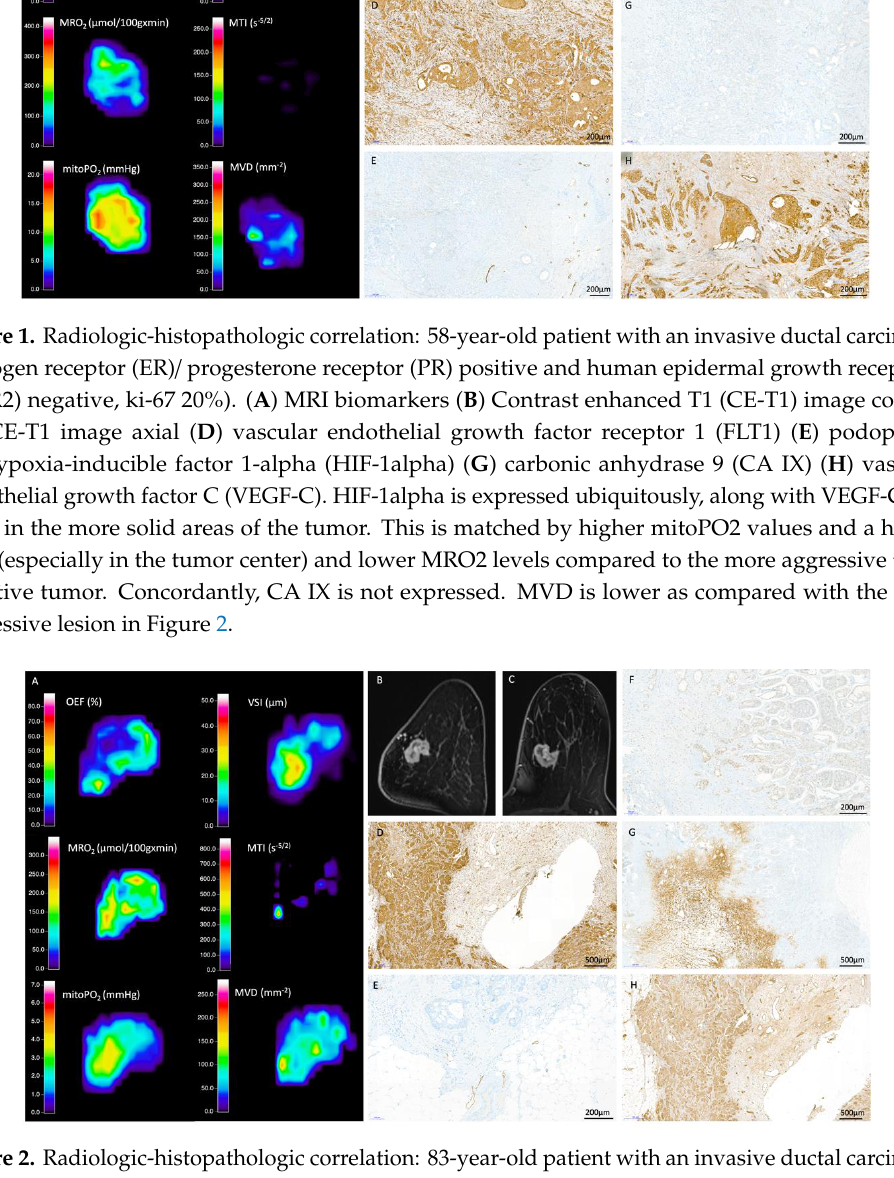
(Table 3). Hypoxia correlated with the proliferation rate and biologic aggressiveness of breast cancer as indicated by immunohistochemistry expression and distribution of common markers of hypoxia (HIF-1alpha, VEGF-C, CA IX, and FLT-1). Figures 1 and 2 exemplify CA IX staining in in a luminal B tumor and a non-luminal triple negative tumor, respectively. CA IX, a marker that is expressed only